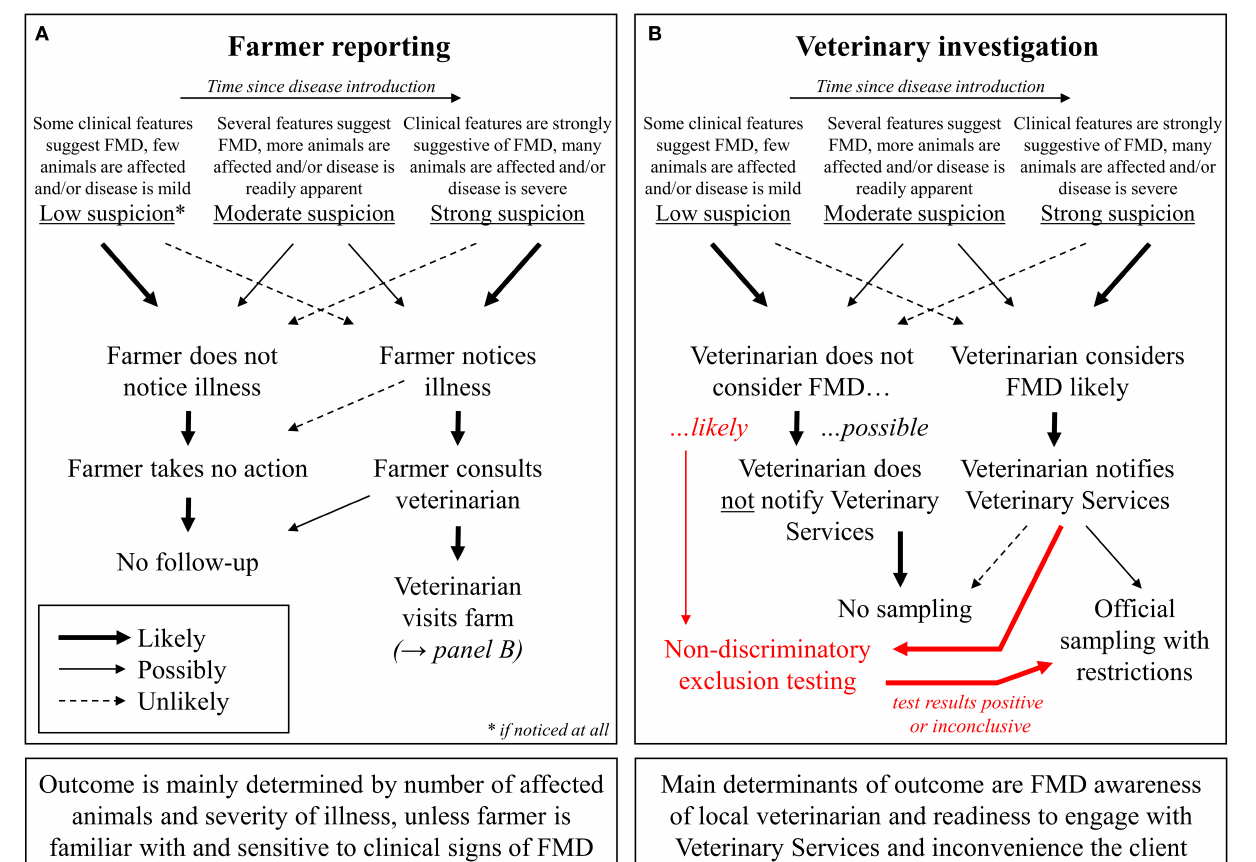
FIGURE 2 | Potential roles of farmers (A) , as well as veterinary practitioners and official veterinarians (B) , in FMD